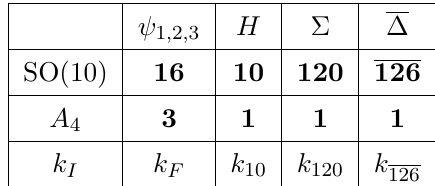
Table 1 . The transformation properties and modular weights of the SO(10) matter fields and Higgs